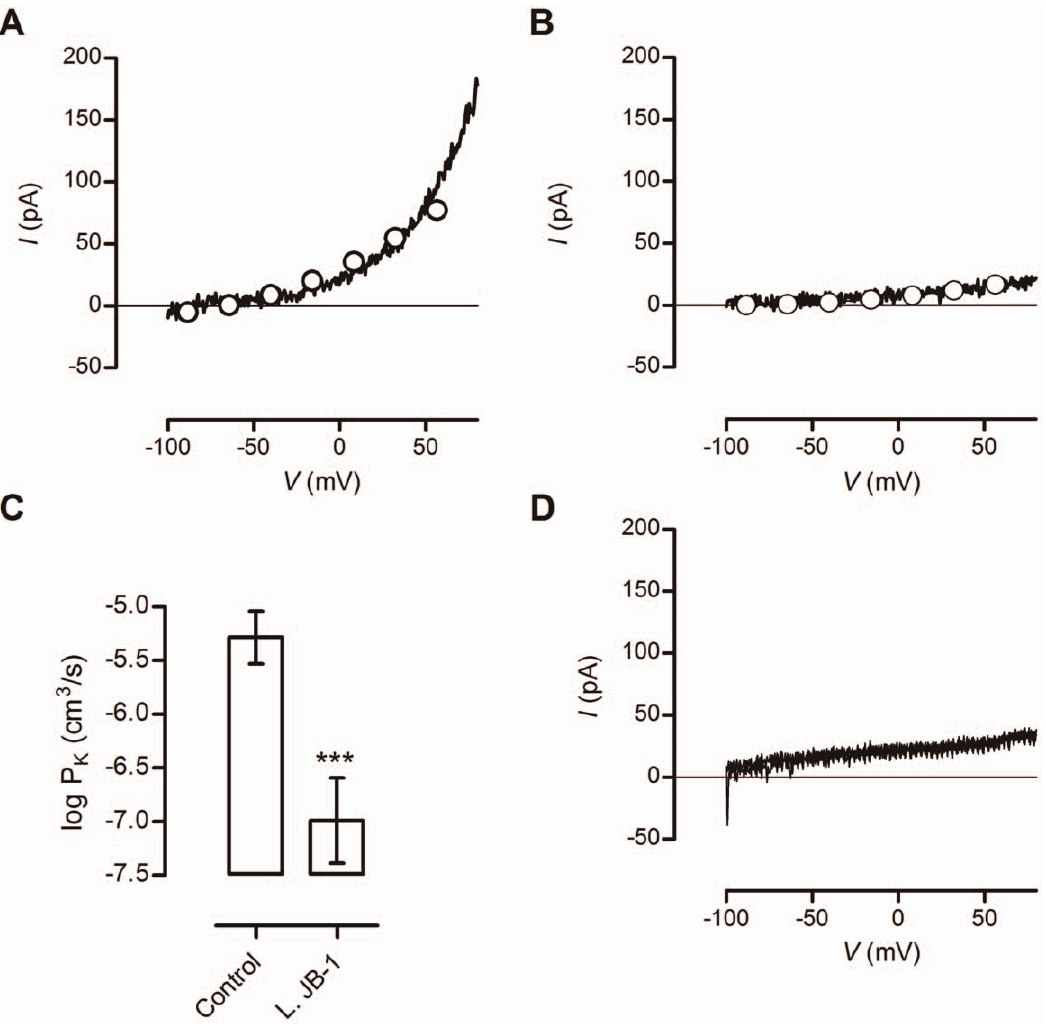
Figure 5. Current – voltage relations for DCEBIO evoked currents in mast cells from L.rhamnosus JB-1 fed or control animals. A) I–V plots of DCEBIO current recorded from mast cell of control animals. The current was fitted with the GHK equation (O) and PK for this cell was determined to be 5.1 6 10 2 6 cm3/s. B) DCEBIO current recorded from mast cell of L.rhamnosus JB-1 fed animal was substantially smaller than that from control animals. For this representative cell PK =1.3 6 10 2 7 cm 3 /s. C) Summary data for DCEBIO current experiments given as mean 6 SEM. Feeding L.rhamnosus JB-1 instead of culture medium substantially blocked the DCEBIO current (P=0.0001). D) Two superimposed traces of I-V plots, the first was performed only Krebs buffer as the perfusate and the second was made when 1 m M DCEBIO was added in the presence of 5 m M TRAM- 34. DCEBIO had no effect in the presence of the IKCa channel blocker TRAM-34, cells were obtained from at least 4 animals in each treatment group, ***=p ,